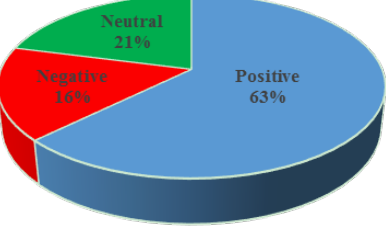
Figure 6. Retweet polarity.